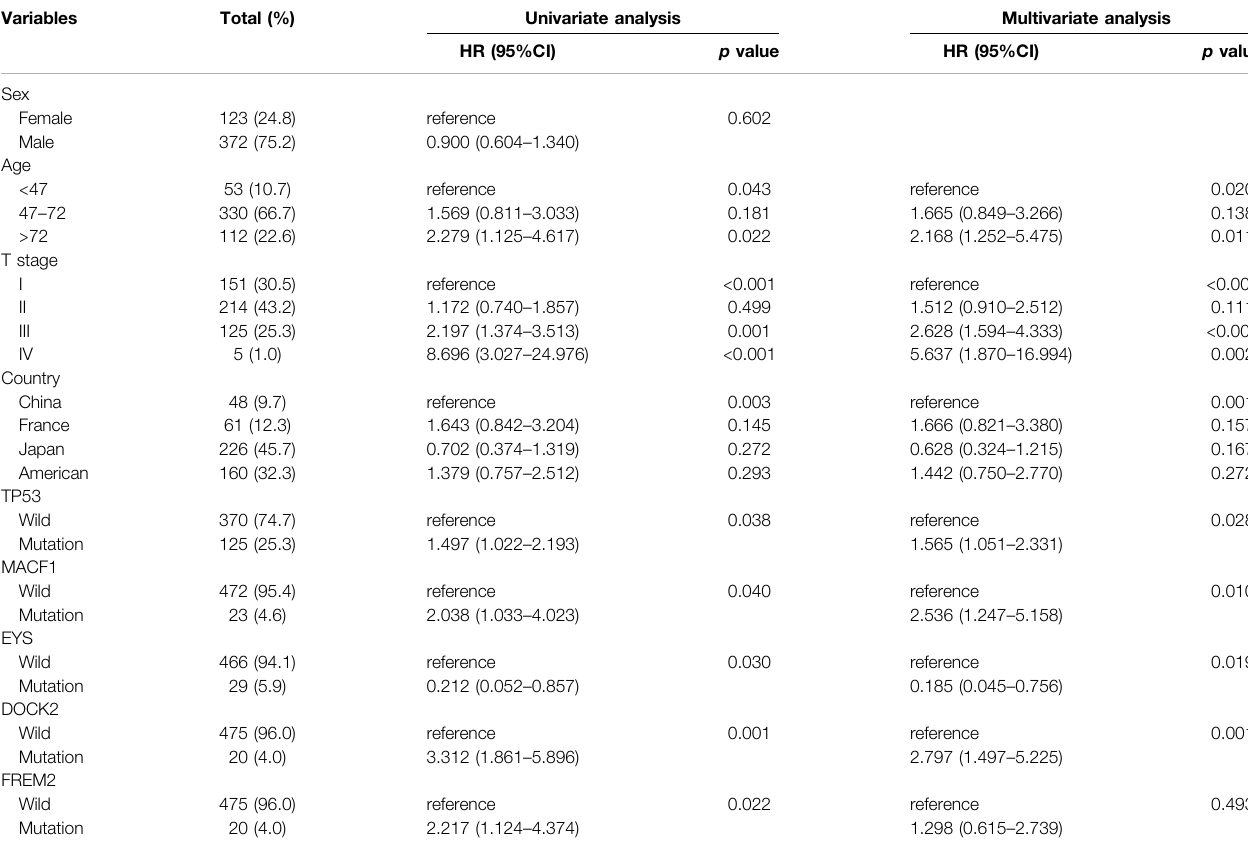
TABLE 2 | Univariate and multivariate analysis of overall survival for patients in the training set (495).